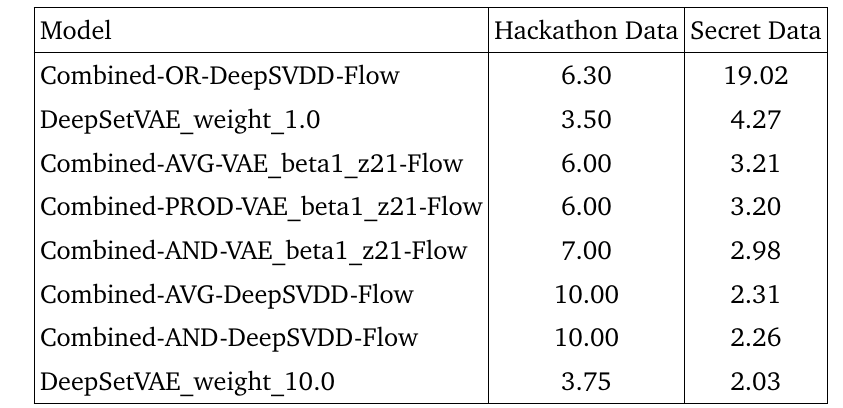
Table 24: The models which have a median TI score greater than 2.0 on both the Hackathon and Secret datasets. The values show the median TI scores on the respec- tive